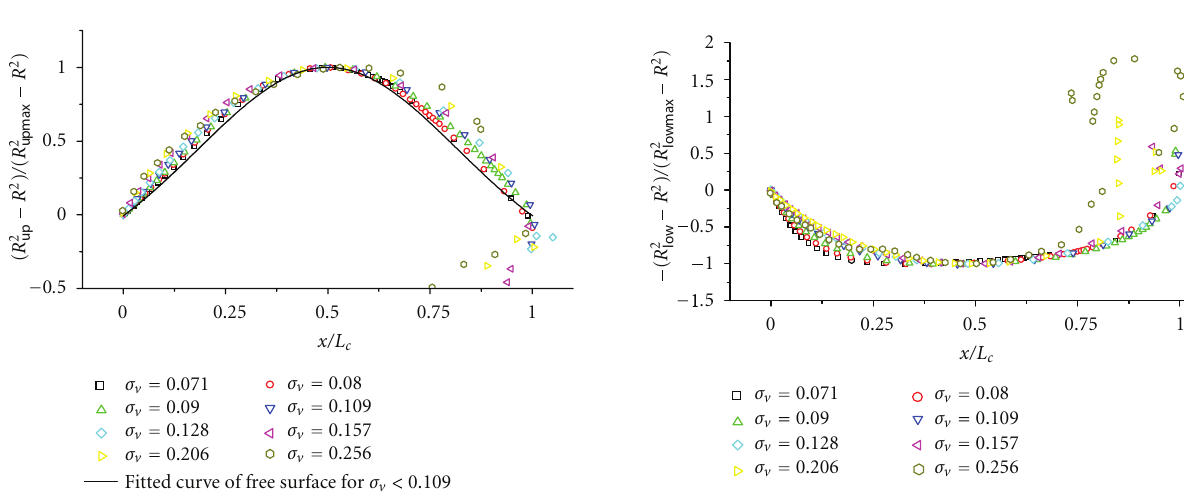
Figure 7: Universal profiles of the upper surface of the cavity at di ff erent σ v , h/H = 0 . 25.